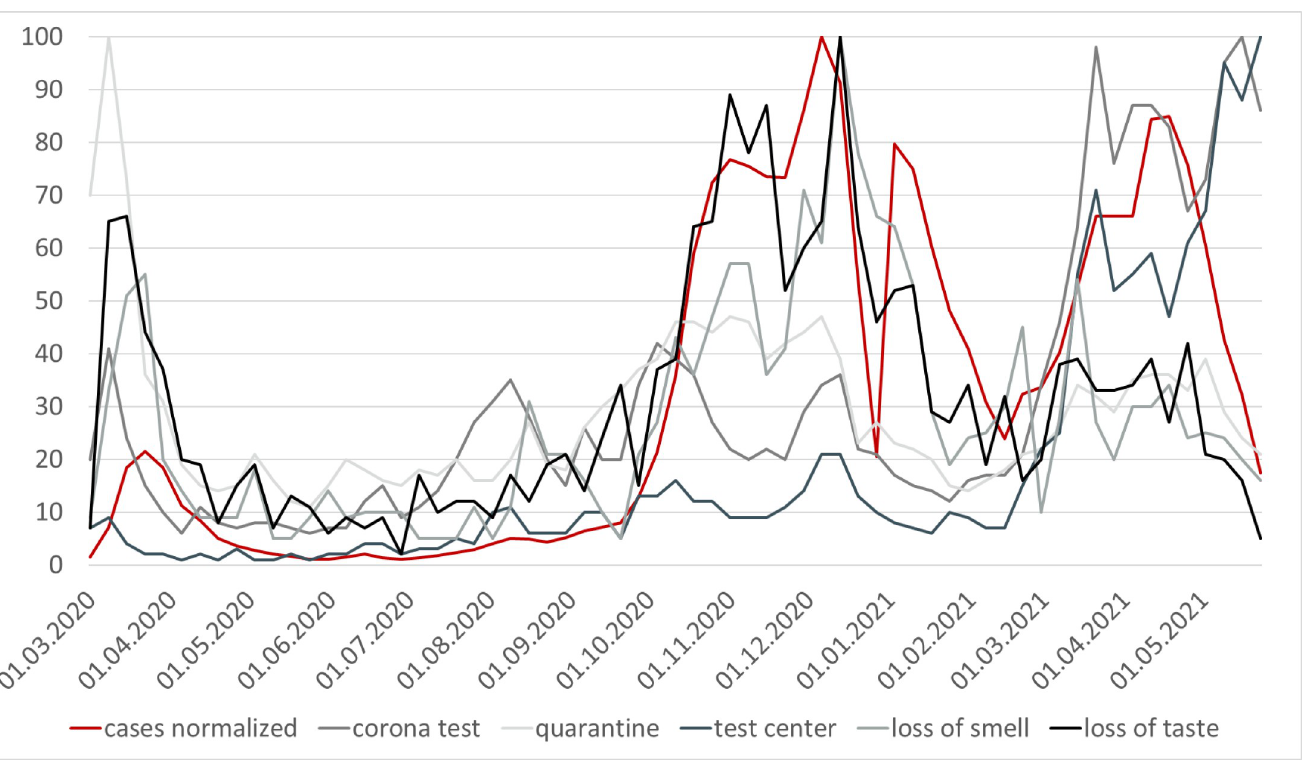
Fig 2. Development of normalized COVID-19 cases and search volume (03/2020–05/2021). Note: Cases normalized to a value between 0 and 100 to achieve better comparability with the search volume.